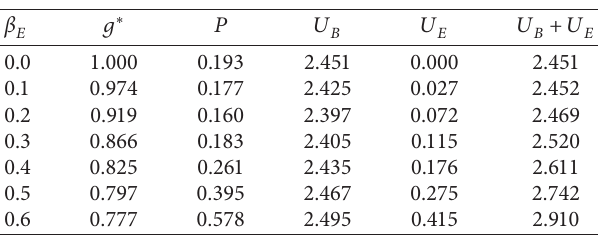
Table 2: The values of optimal PSR and expected utilities under different β E